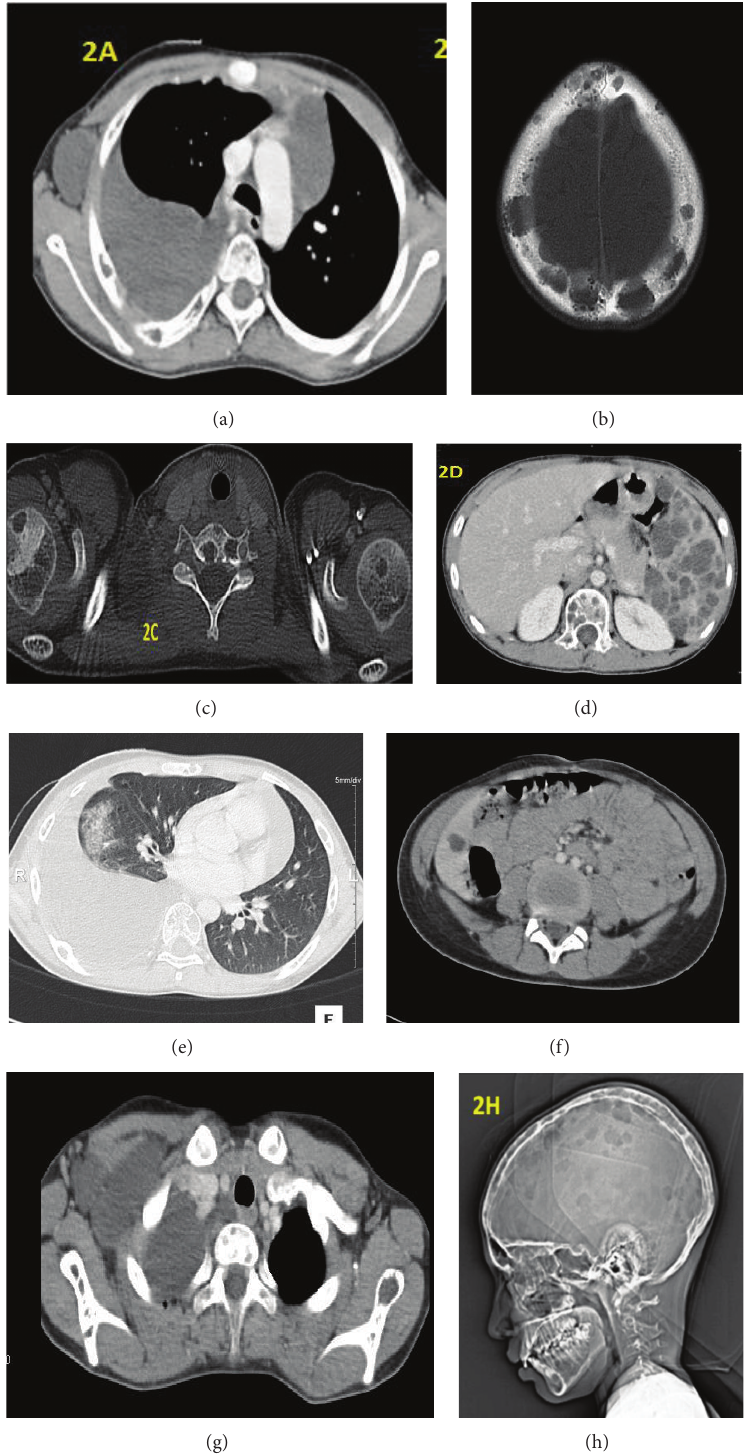
Figure 2: (a) CT scan chest (axial section) showing right pleural effusion, left mediastinal effusion, right chest wall hypodense lesion, and osteolytic lesions in ribs on right side. (b) CT scan skull (bony window) showing multiple osteolytic lesions without marginal sclerosis. (c) CT scan through shoulders (bony window) showing osteolytic lesions in head of each humerus without marginal sclerosis and vertebral body lesion with marginal sclerosis. (d) CT scan abdomen showing multiple cystic lesions in spleen with splenomegaly and osteolytic lesions in vertebra. (e) CT scan thorax (pulmonary window) showing pulmonary lymphangioma appearing as nonhomogenous consolidation with few small cystic hypodense shadows laterally with right pleural effusion. (f) CT scan abdomen showing hypodense lesion in liver. (g) CT scan of upper chest showing hypodense lesion in right axilla and pleural effusion with hypodense lesion in left scapula. (h) Skull topography showing multiple osteolytic “punched-out”